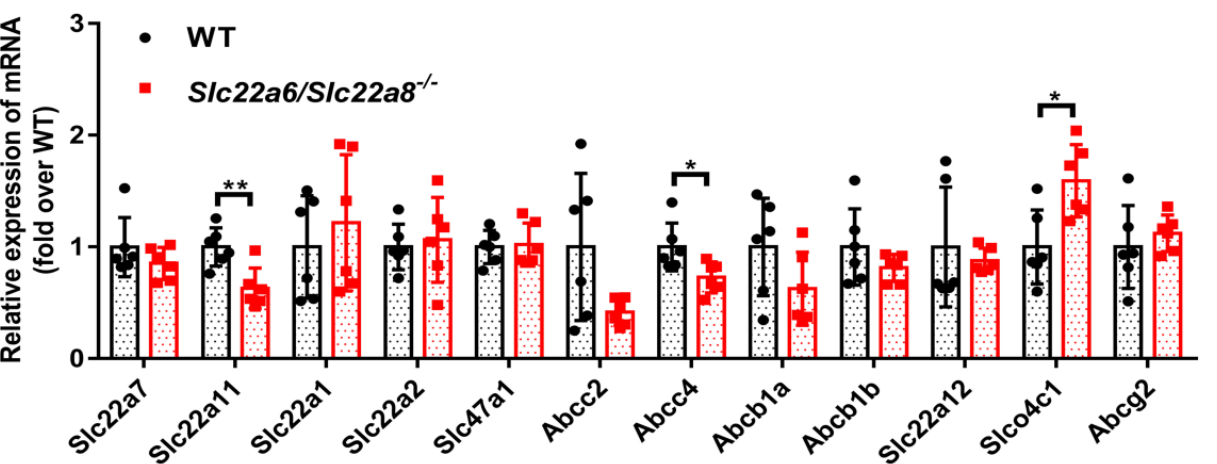
Figure 5. Effects of Slc22a6 / Slc22a8 double-knockout on the mRNA expression of major transporters in the kidneys of WT and KO rats. Q-PCR was used to detect the mRNA expression of the trans- porters. Among them, Slc22a7 , Slc22a11 , Slc22a1 , Slc22a2 , Slc22a12 and Slco4c1 are uptake trans- porters, and Slc47a1 , Abcc2 , Abcc4 , Abcb1a , Abcb1b , Abcg2 are efflux transporters. Data are presented as mean ± SD (n = 6). *, p < 0.05; **, p < 0.01 compared with WT rats.